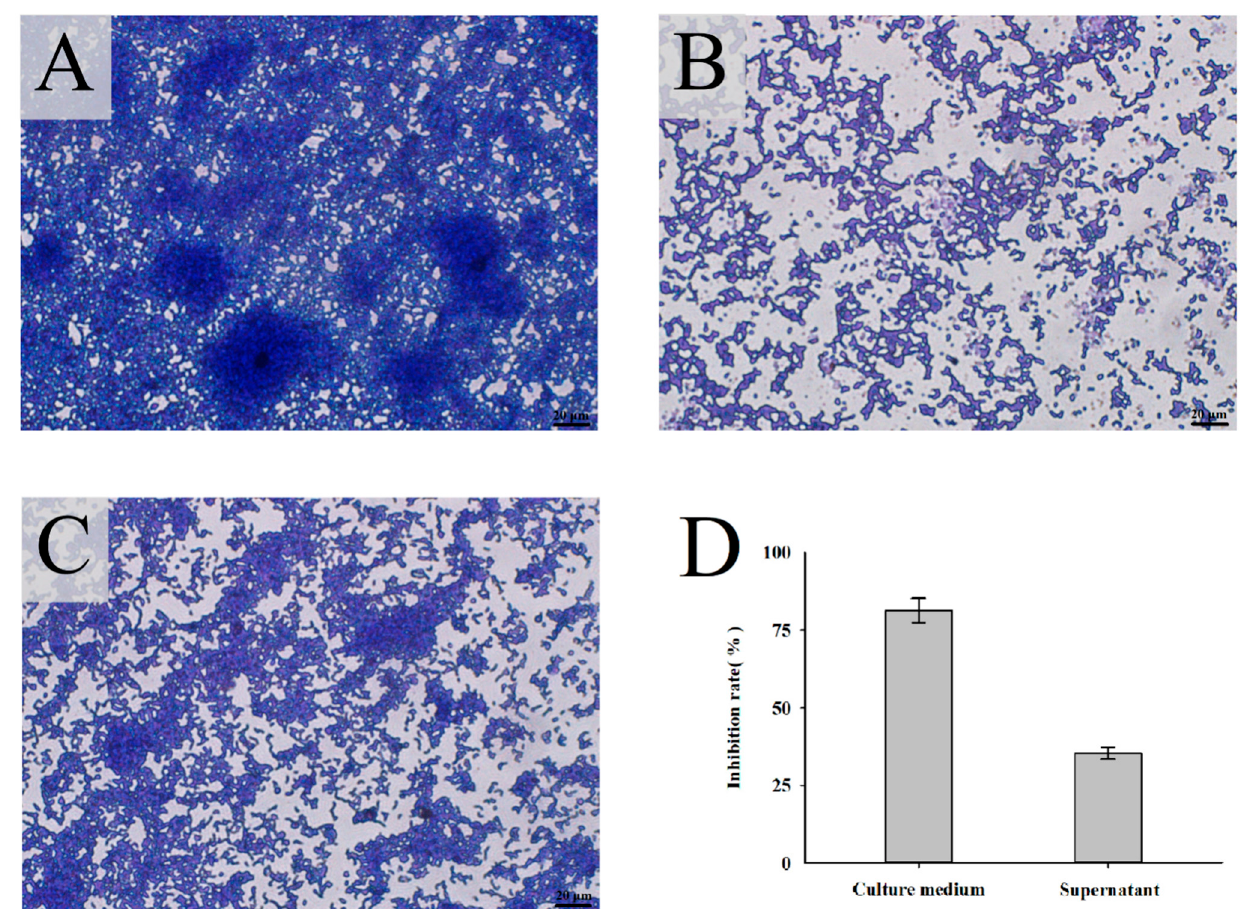
Figure 2. Microscopy images of P. gingivalis biofilm treated with L. mesenteroides LVBH107. P. gingivalis biofilm stained with crystal violet after cultured for 48 h. ( A ) Untreated control. ( B ) Treatment with L. mesenteroides LVBH107 culture medium. ( C ) Treatment with the supernatant of L. mesenteroides LVBH107. ( D ) Inhibition rate of L. mesenteroides LVBH107 on biofilm formation of P. gingivalis . Scale bar = 20 μ m.